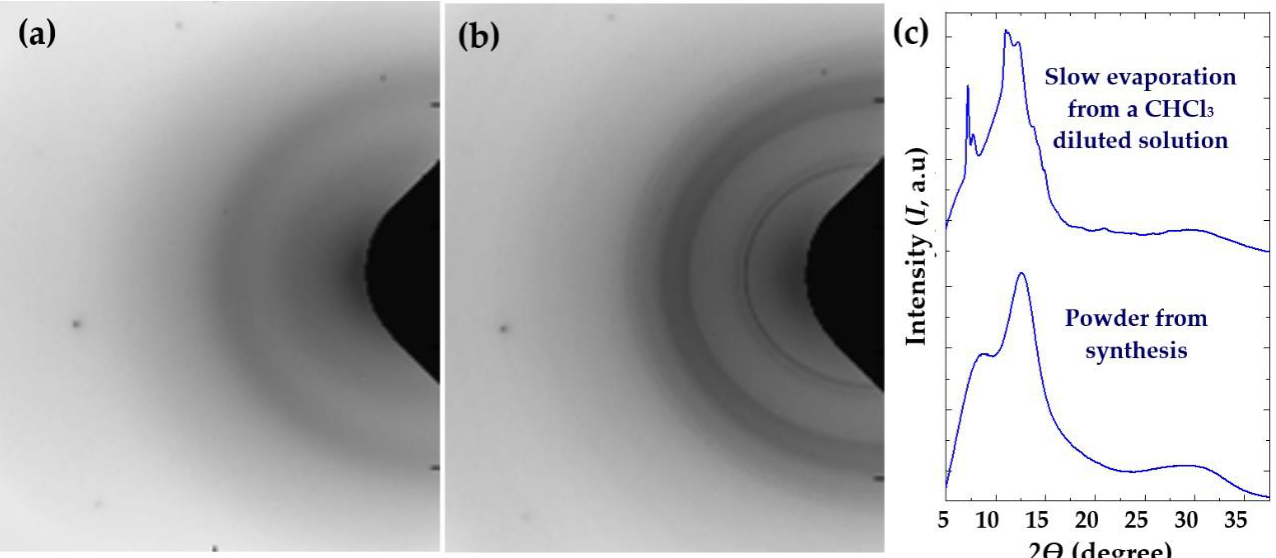
Figure 7. Bidimensional X-ray diffraction patterns of PLC as obtained from synthesis ( a ) and after slow evaporation of a chloroform solution ( b ). The corresponding linear X-ray profiles are given in ( c ).